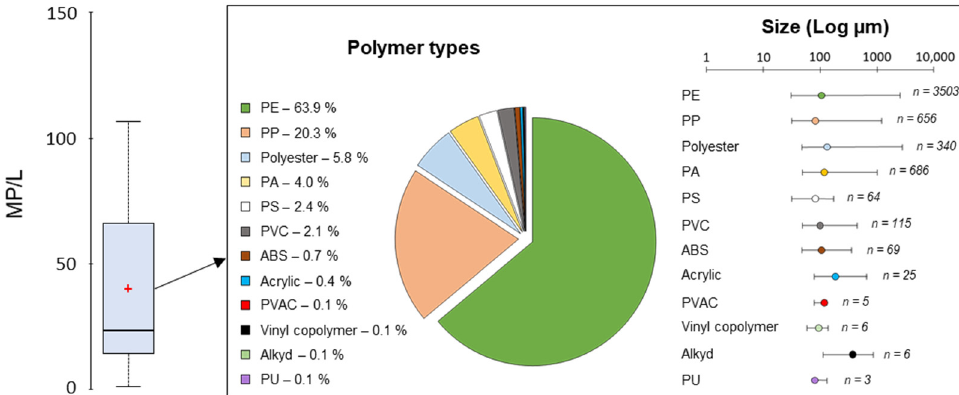
Figure 4. Boxplot representing the variability (first quartile, third quartile and median; red cross: mean value; vertical bars: 1.5 times the interquartile range) of MP concentrations (in MP/L, MP > 25 µ m) in all samples. Percentages and major dimensions (minimum, maximum and median values) of the 12 polymer types identified are indicated.